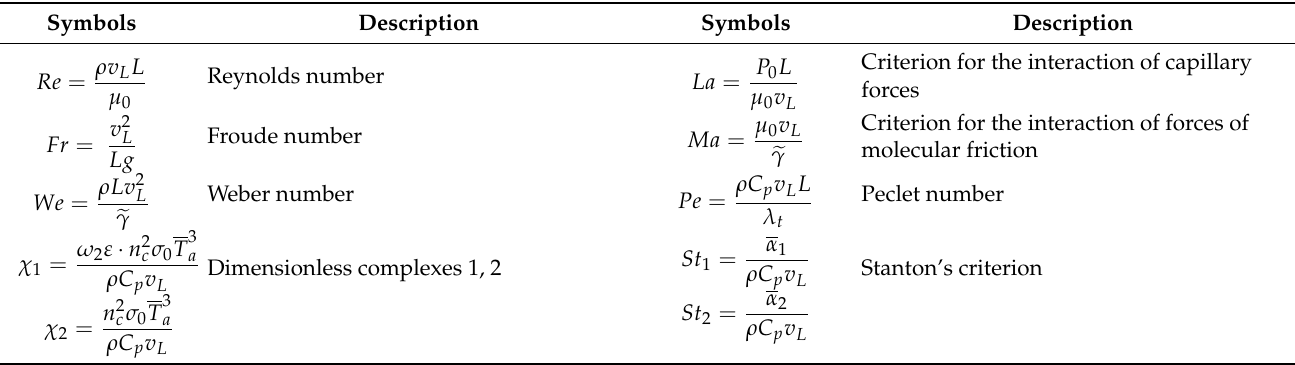
Table 2. Dimensionless